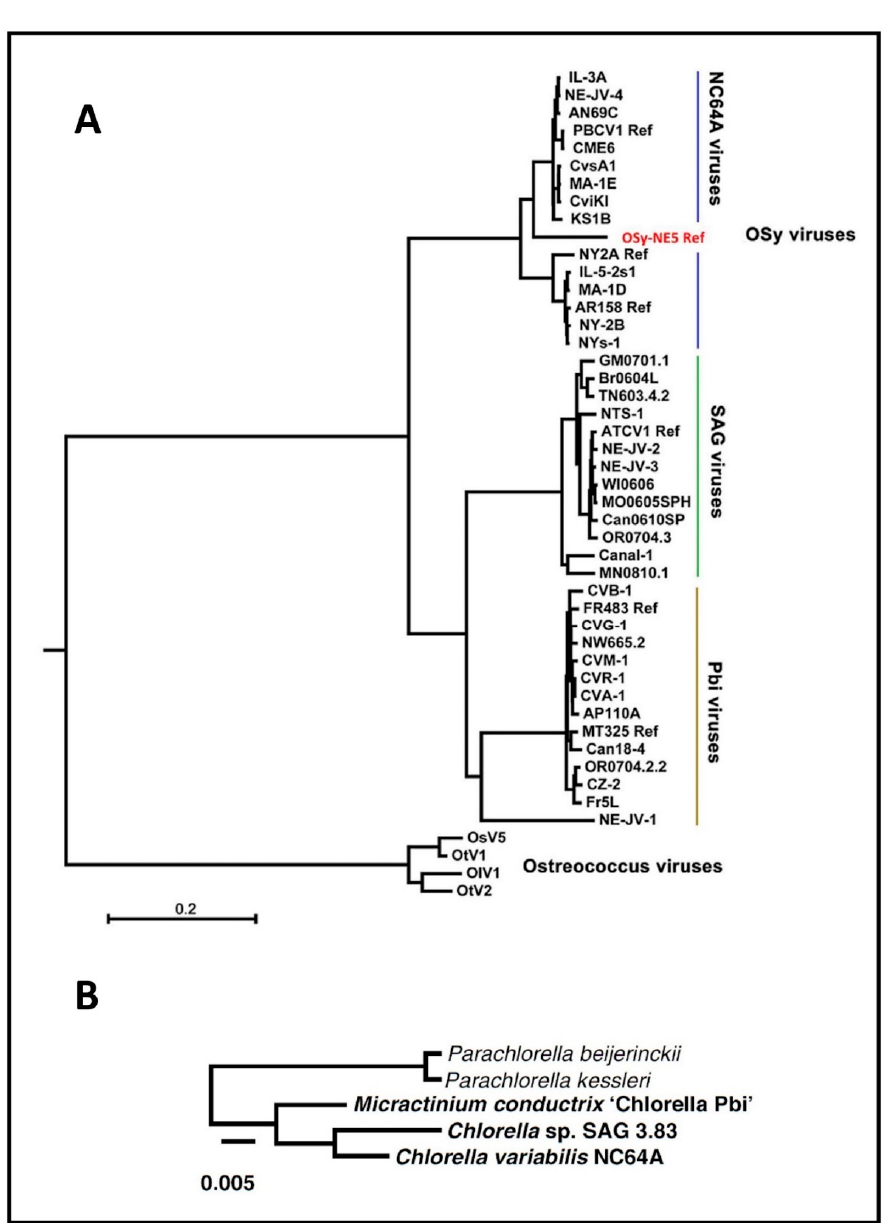
Figure 13. Phylogenies of chloroviruses and algal hosts. ( A ) Phylogenetic tree shows the evolutionary relationships between 47 chloroviruses concatenated amino acid sequences (7762 gap-free sites). The Maximum Likelihood tree was constructed using the MEGA 6.0 software with the Maximum Likelihood algorithm and default setting. The bar length represents 0.2 substitutions per amino acid site. A recently characterized Osy chlorovirus species is indicated in red and resides between the separate phylogenetic subclades of NC64A viruses; one subclade contains PBCV-1 while the other subclade contains chlorovirus NY-2A. Both subclades share almost perfect gene colinearity and they replicate in the same host. Branch support was estimated from 1000 bootstrap replicates. Four Ostreococcus virus sequences served as outgroups to root the tree. ( B ) Maximum Likelihood tree of three algal hosts based on 18S RNA alignment (2266 gap-free sites). The phylogenetic tree was computed using the GTR + G + I substitution model. All interior branches received maximal support (100%). Parachlorella species served as the outgroup. Panel A is from Quispe et al. [94] and panel B is from Jeanniard et al. [93], both are published with permission.